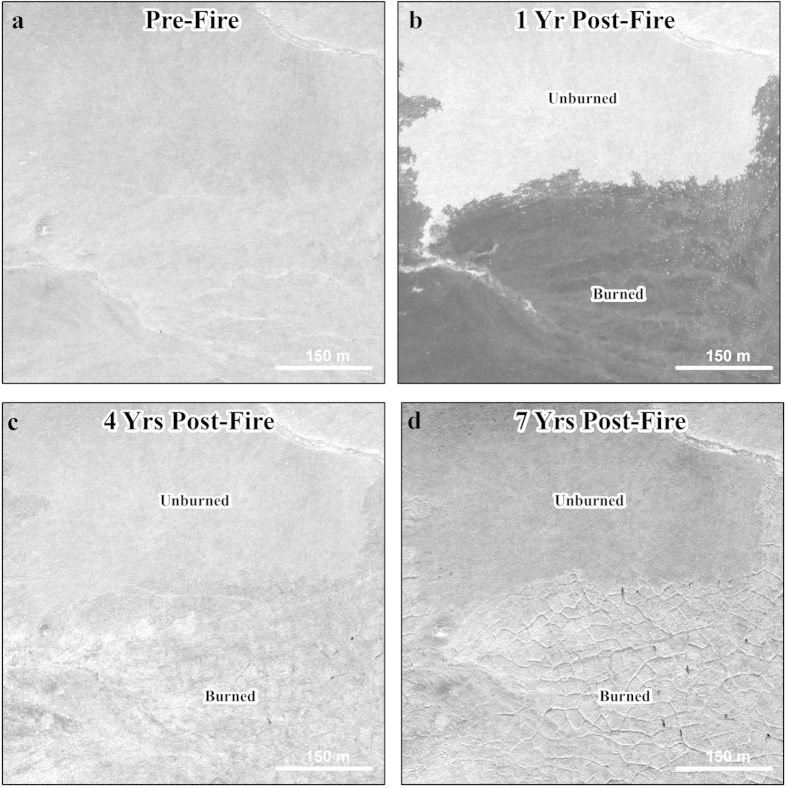
Time series of high-resolution (<1 m) satellite imagery (copyright DigitalGlobe, Inc.) showing ice wedge degradation associated with burned upland (yedoma) tundra.(a) A Quickbird image from 27 June 2006, the year prior to the Anaktuvuk River fire. (b) A Quickbird image from 05 July 2008, the year following the fire, showing a portion of the northern extent of the burn area. (c) A Worldview-1 image from 02 July 2011, four years following the fire, showing subtle, initial signs of ice wedge degradation. (d) A Worldview-1 image from 06 September 2014, seven years following the fire, showing widespread ice wedge degradation in the burned area. All panels show the same location and the imagery indicates that ice wedge degradation became ubiquitous after 2011 (4 yrs post-fire). Figure created in Esri® ArcMap™ 10.1.